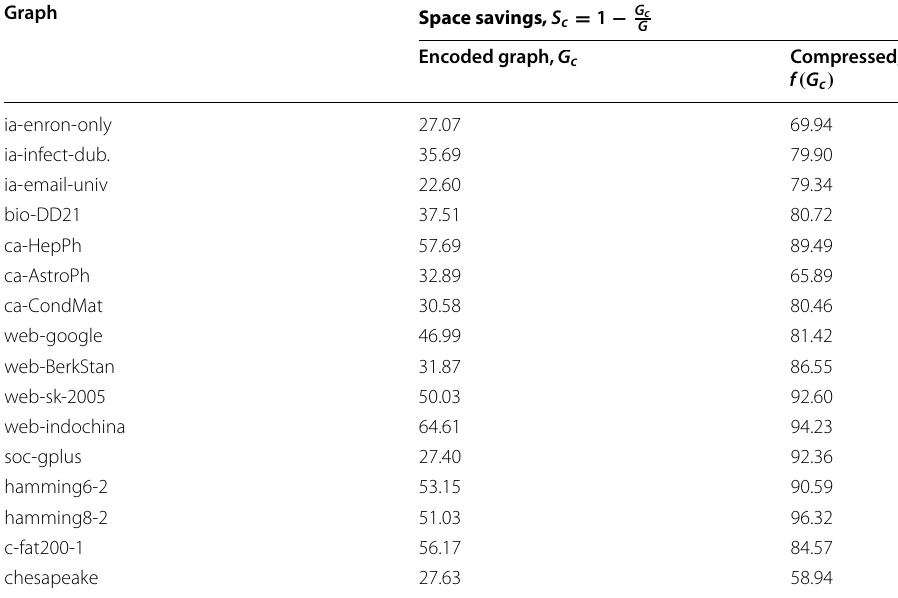
Table 2 Results comparing the encoded graph G c to the compressed f ( G c ) Graph